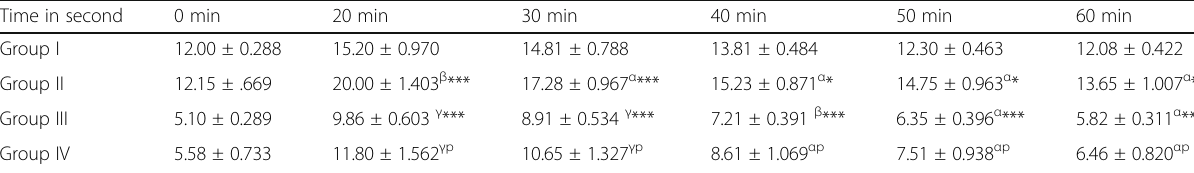
The values represent as Mean ±SEM for 6 rats each. The results are expressed in pg/mL. α =( P > 0.05), β = ( P < 0.05), γ = ( P < 0.01) represents comparison of 0 min reading of each group with 20,30,40,50 and 60 min. *= ( P >0.05), ** =( P < 0.05), ***= ( P <0.01) represents comparison of Group-III with Group-I. p = P > 0.05), q =( P <0.05), r = ( P <0.01) compared Group IV with Group III. Group-I Normal Control; Group-II Normal treated (AEMC); Group-III Diabetic control; Group-IV diabetic treated